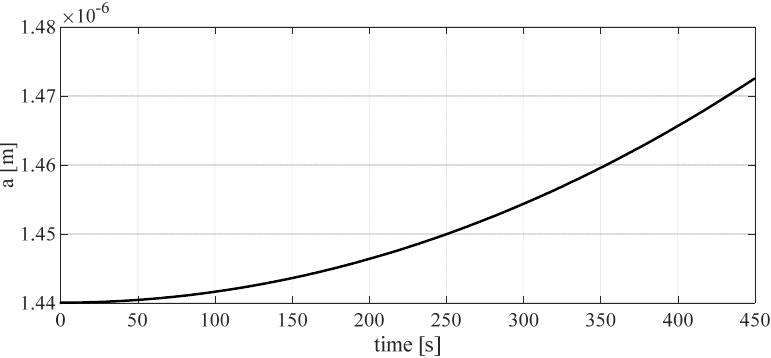
Figure 14. Dynamic behavior of the fissure inside the PMSM rotor.